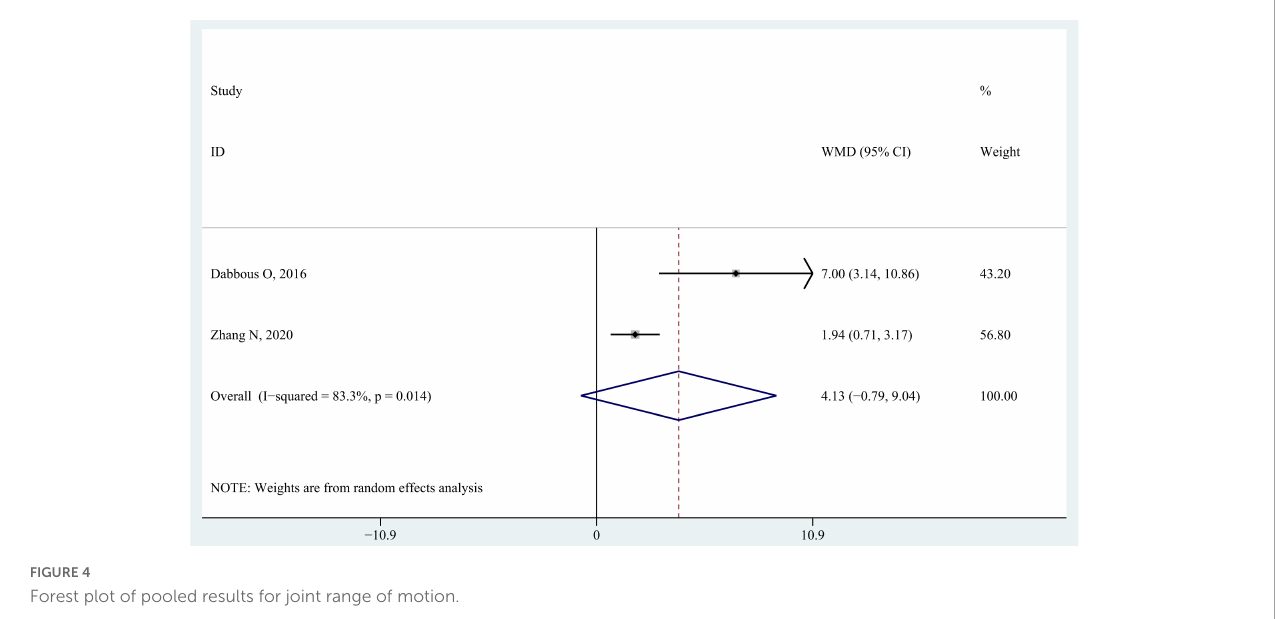
FIGURE4 Forest plot of pooled results for joint range of motion.